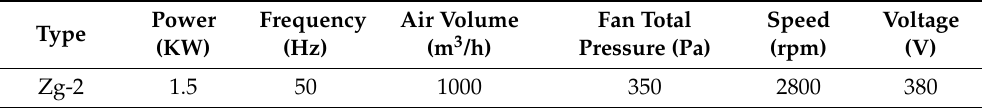
Table 2. The parameters of ZG fan-2. Figure 10. Photo of ZG-2 fan.